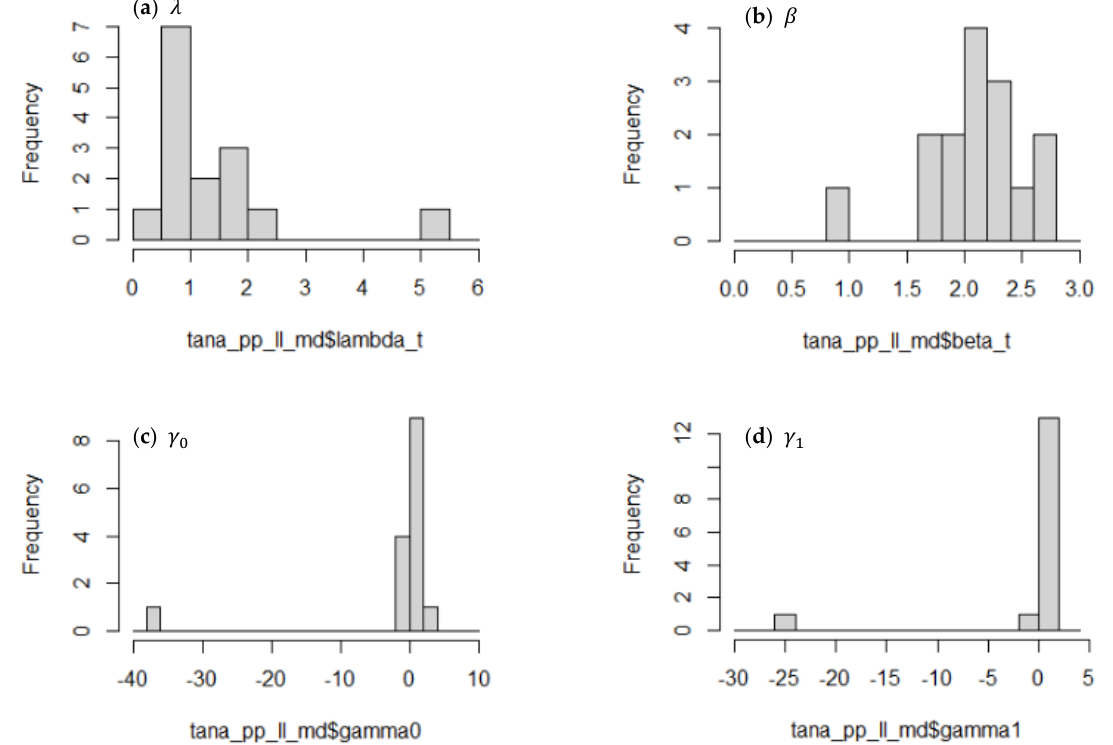
Figure A3. Histogram of estimated parameters for each module.